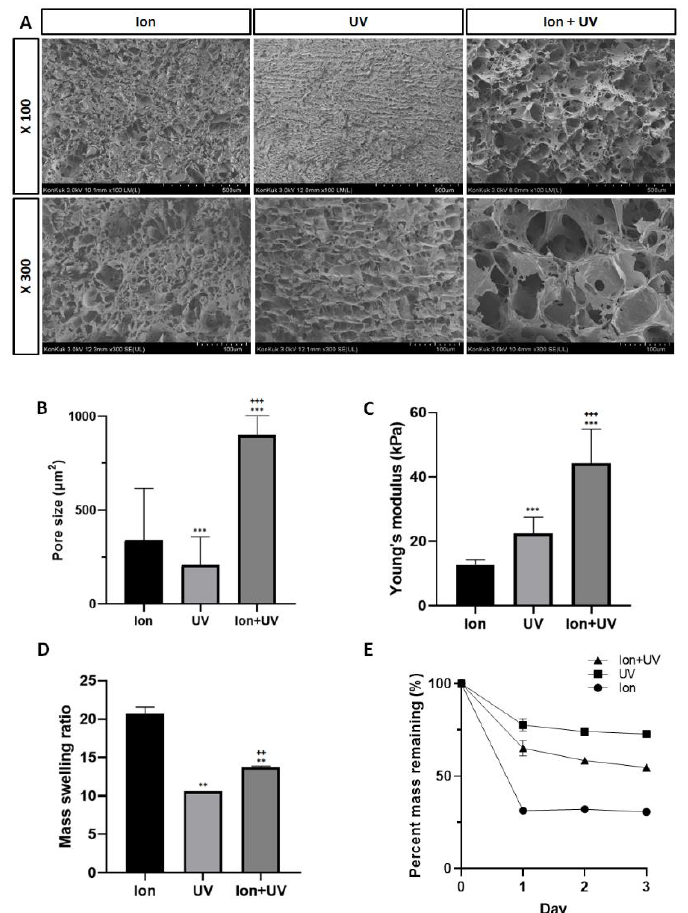
Figure 3. Pore distribution and mechanical analysis. ( A ) Scanning electron microscopy images of bioink prepolymer solutions cross-linked under three different conditions (ion, UV, and ion + UV). ( B ) Pore size analysis of bioink cross-linked under three different conditions (ion, UV, and ion + UV). The average pore size value for each cross-linking condition was 339.29 ± 275.01, 207.4 ± 149.09, and 897.74 ± 365.84 µ m 2 for ion, UV, and ion + UV, respectively ( n = 8). ( C ) Young’s modulus of cross-linked bioink. Average young’s modulus for each cross-linking condition was 12.75 ± 1.35, 22.43 ± 4.71, and 44.19 ± 9.76 kPa for ion, UV, and ion + UV, respectively ( n = 6). ( D ) Mass swelling ratio ( n = 2) and ( E ) Percent mass remaining (%) of bioink prepolymer solutions cross-linked under three different conditions (ion, UV, and ion + UV) ( n = 3). (*, + indicates vs. ion and UV. *** p < 0.001, ** p < 0.01, +++ p < 0.001, ++ p <